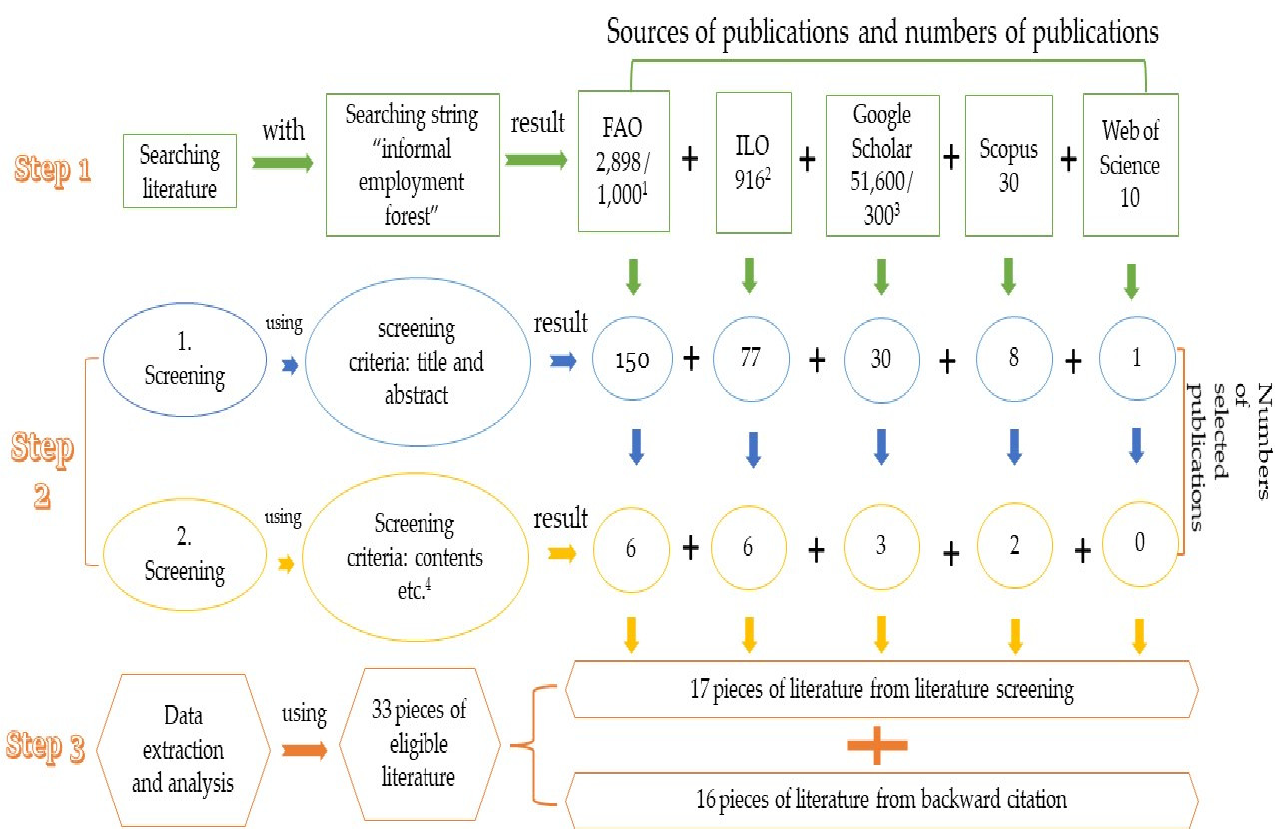
Figure 1. The procedure of literature screening. 1 The searching result is 2898 pieces of literature, and we used the first 1000 publications. 2 The searching result is 916 pieces of literature, and we used all. 3 The searching result is 51,600 pieces of literature, and we used the first 300 publications.